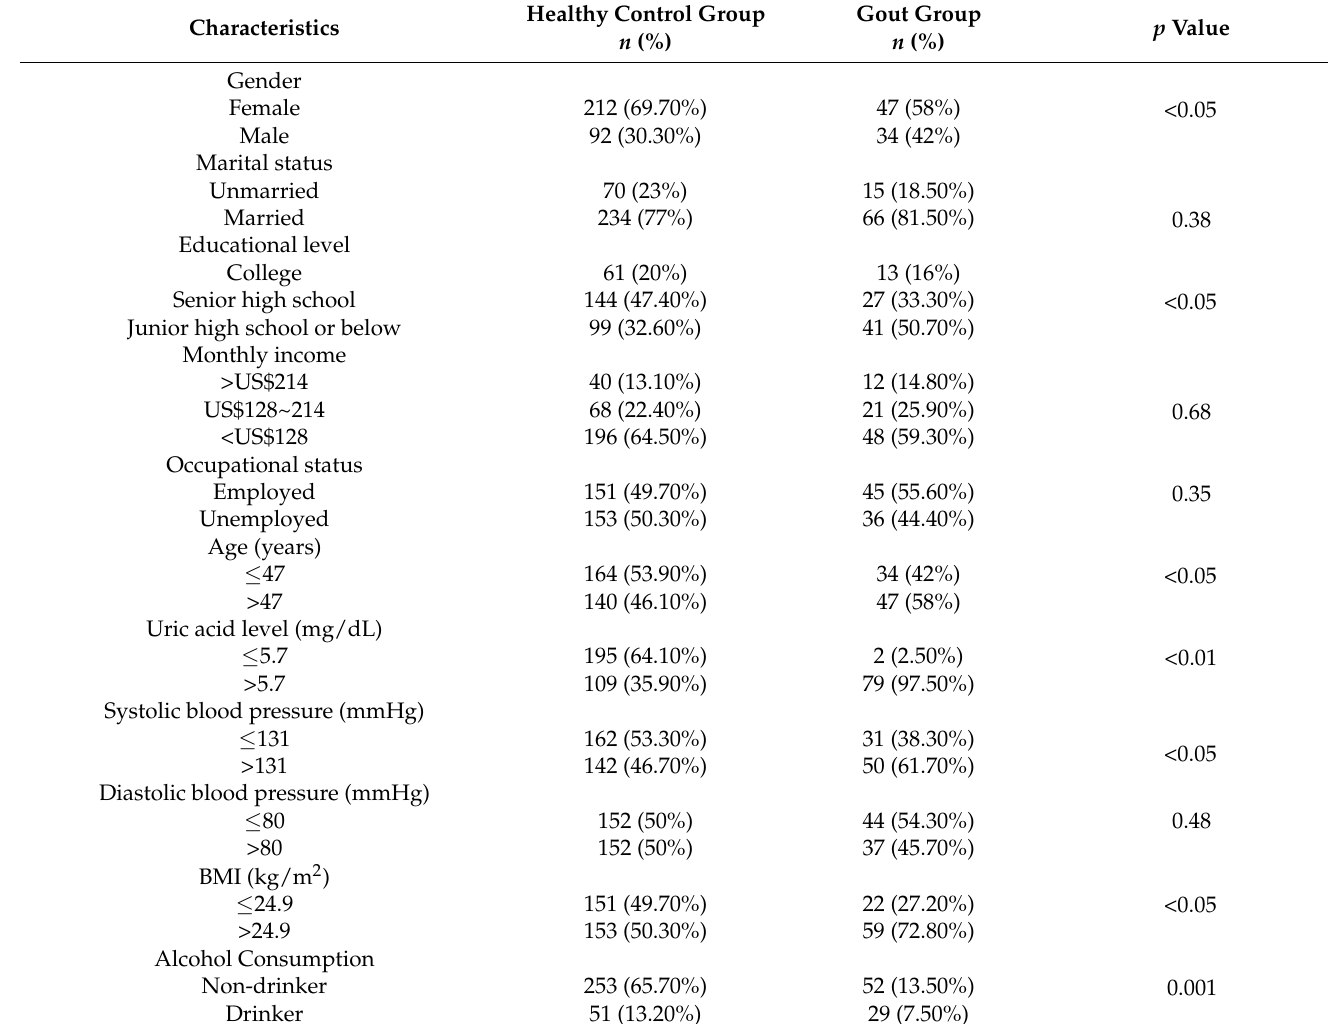
Table 1. Distributions of Demographic Characteristics Between Healthy Controls and Patients with Gout ( N = 385).